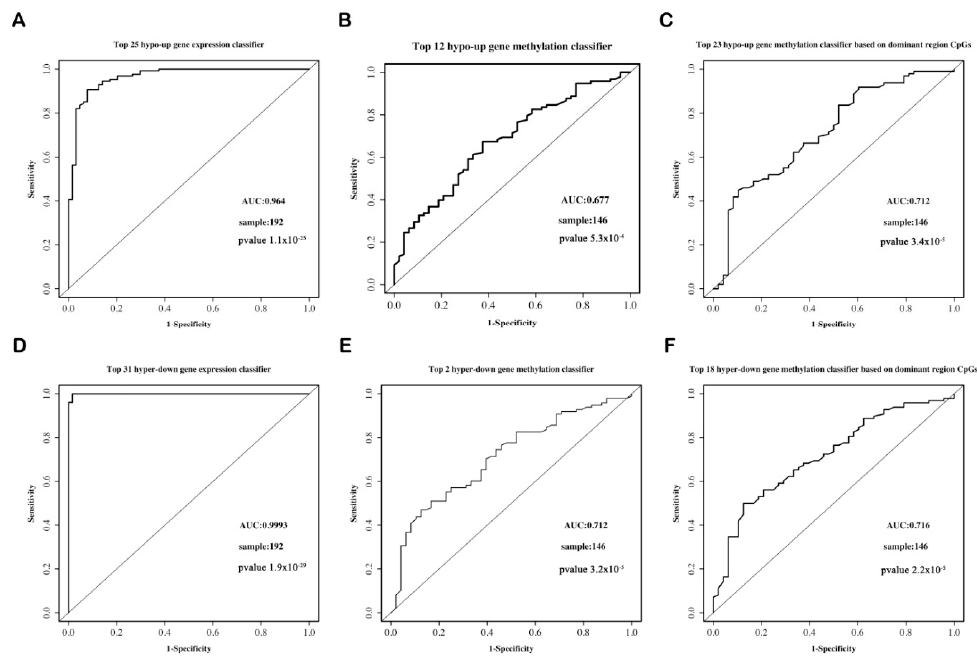
Figure 9. ROC curves for the hypo-up genes and hyper-down gene classifiers. ( A ) Top 25 hypo-up gene expression classifier. ( B ) Top 12 hypo-up gene methylation classifier based on the CpGs in all of the regions. ( C ) Top 23 hypo-up gene methylation classifier based on the CpGs in the dominant regions. ( D ) Top 31 hyper-down gene expression classifier. ( E ) Top 2 hyper-down gene methylation classifier based on the CpGs in all of the regions. ( F ) Top 18 hyper-down gene methylation classifier based on the CpGs in the dominant regions. ROC, receiver operating characteristic; AUC, area under the curve.